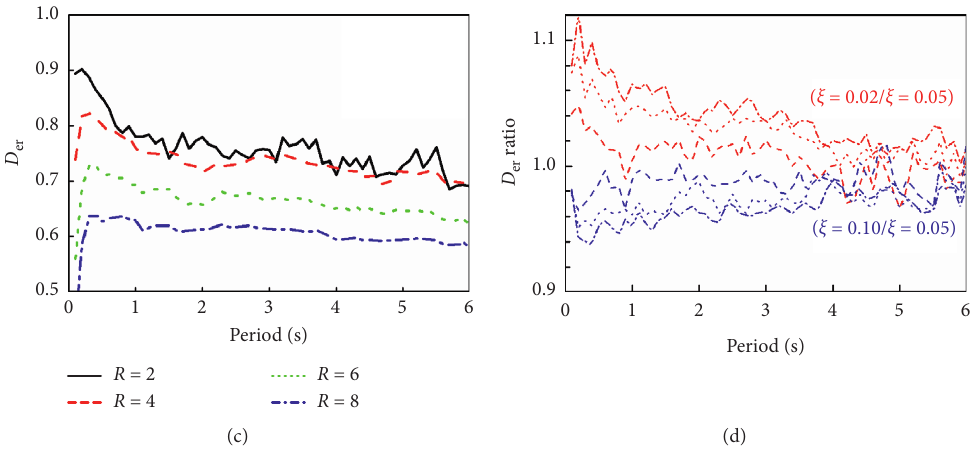
Figure 3: Duration spectrum for different damping ratios. (a) ξ � 0.02. (b) ξ � 0.05. (c) ξ � 0.10. (d) Ratio.